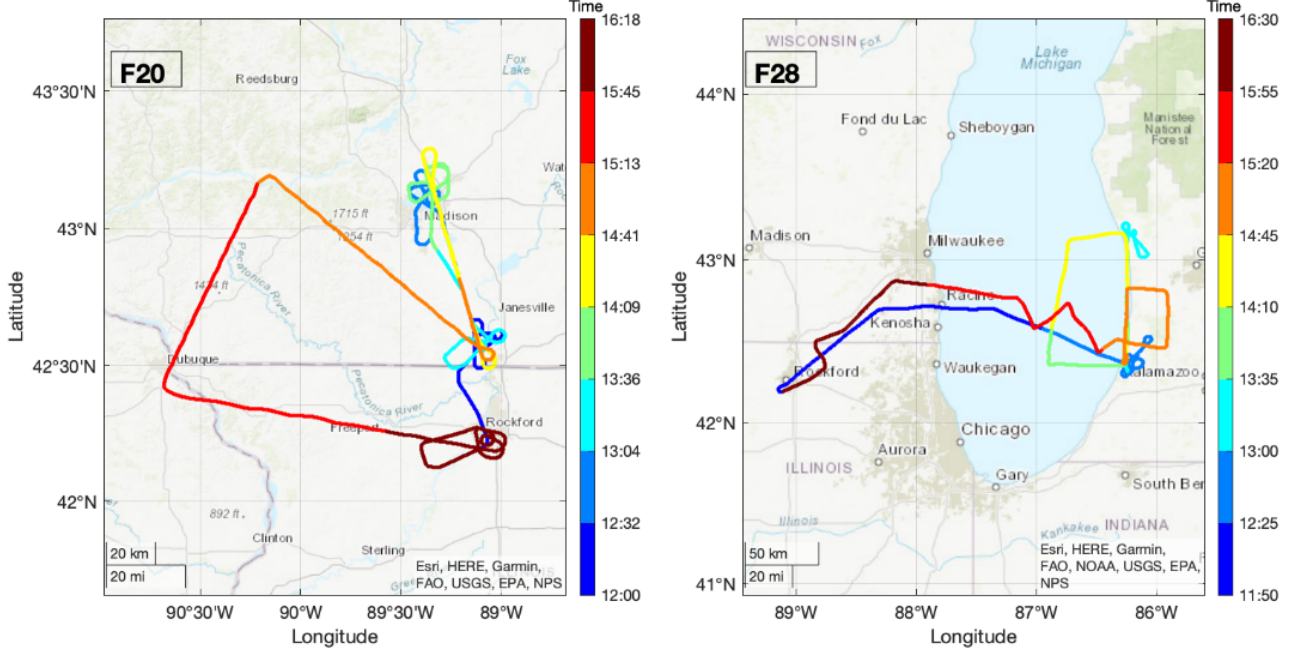
Figure 2. Flight tracks of the NRC Convair-580 aircraft for two selected flights: F20 on 23 February 2019 and F28 on 5 March 2019. Color coding shows UTC time progression along the flight track.